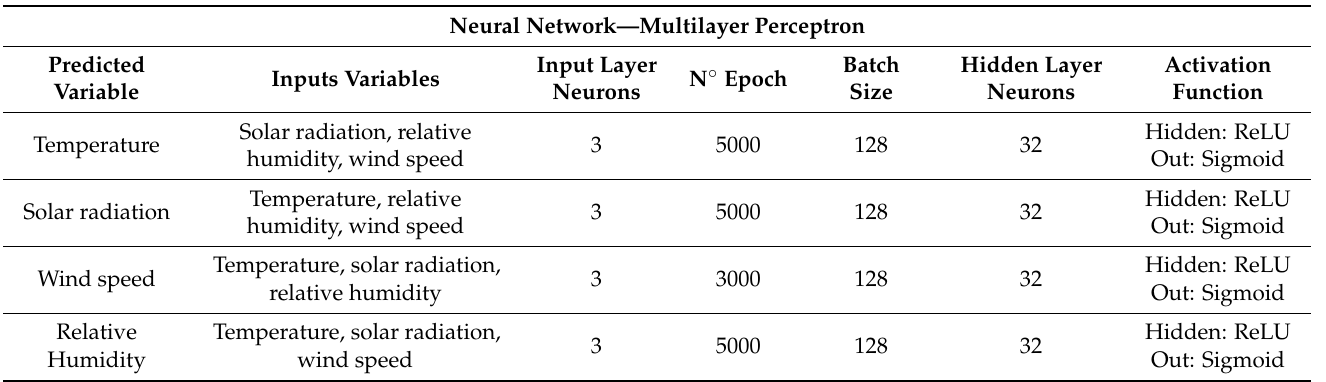
Table 6. Tuning parameters for the multilayer perceptron neural network technique.